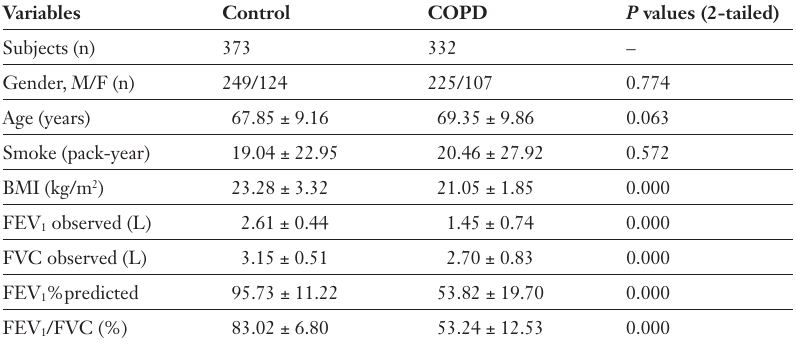
Characteristics of the study